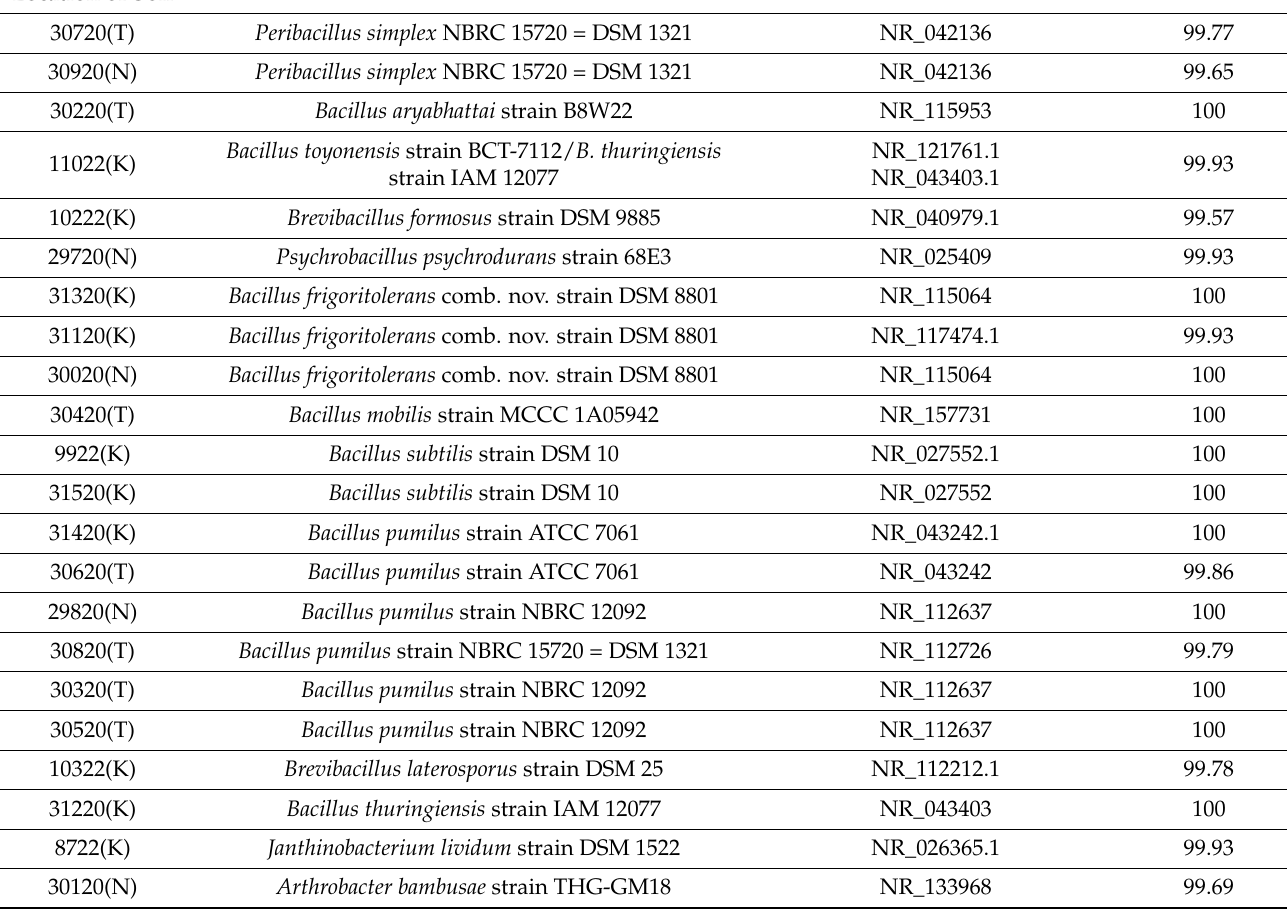
Table 2. Putative identification of bacteria (isolated from the soils) by means of 16S rRNA (~1390 bp) gene